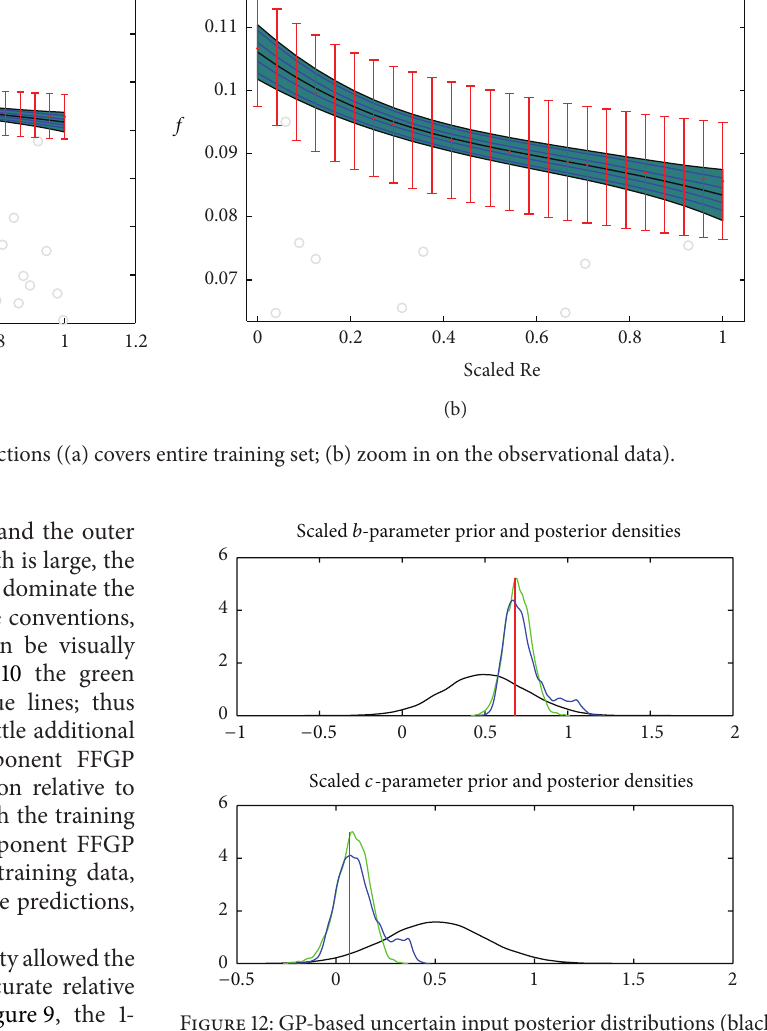
Figure 12: GP-based uncertain input posterior distributions (black: prior, blue: emulator-based posterior, green: computer code-based posterior, and red: true